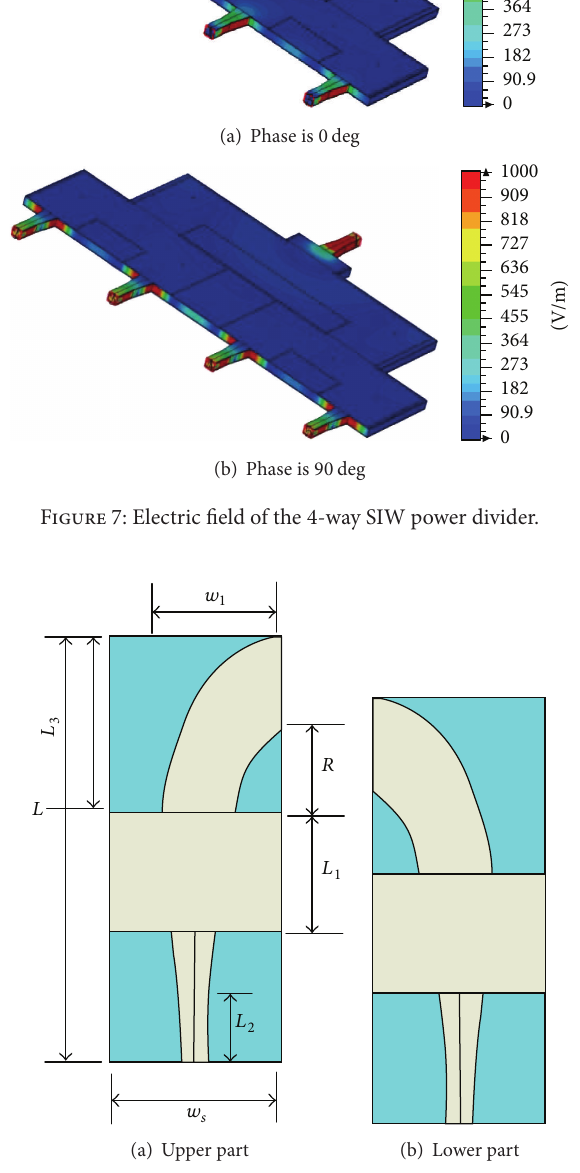
Figure 8: Antipodal Vivaldi antenna